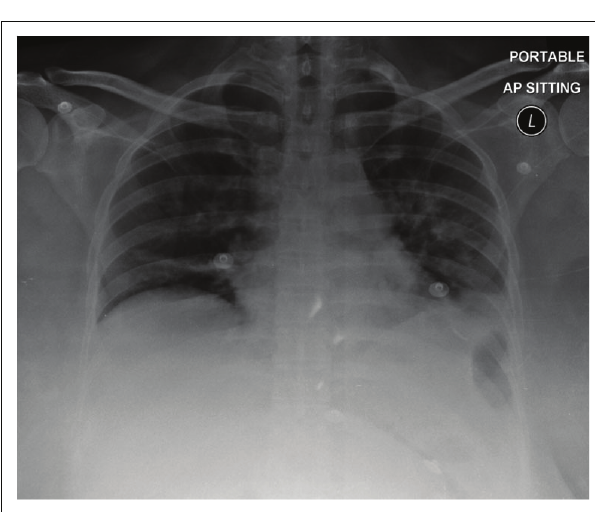
FIGURE 4: A 36-year-old female admitted to an isolation ward with COVID-19 pneumonia. Portable antero-posterior (AP) chest radiograph demonstrates blunting of the left costophrenic angle suggesting a pleural effusion as well as bilateral air space opacities. Brixia score: 13.